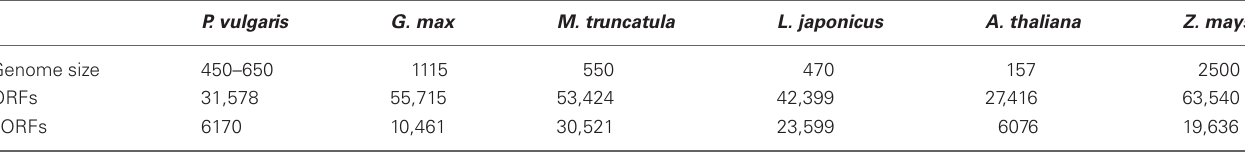
Genome annotations and plant genome databases consulted are described in Materials and Methods.